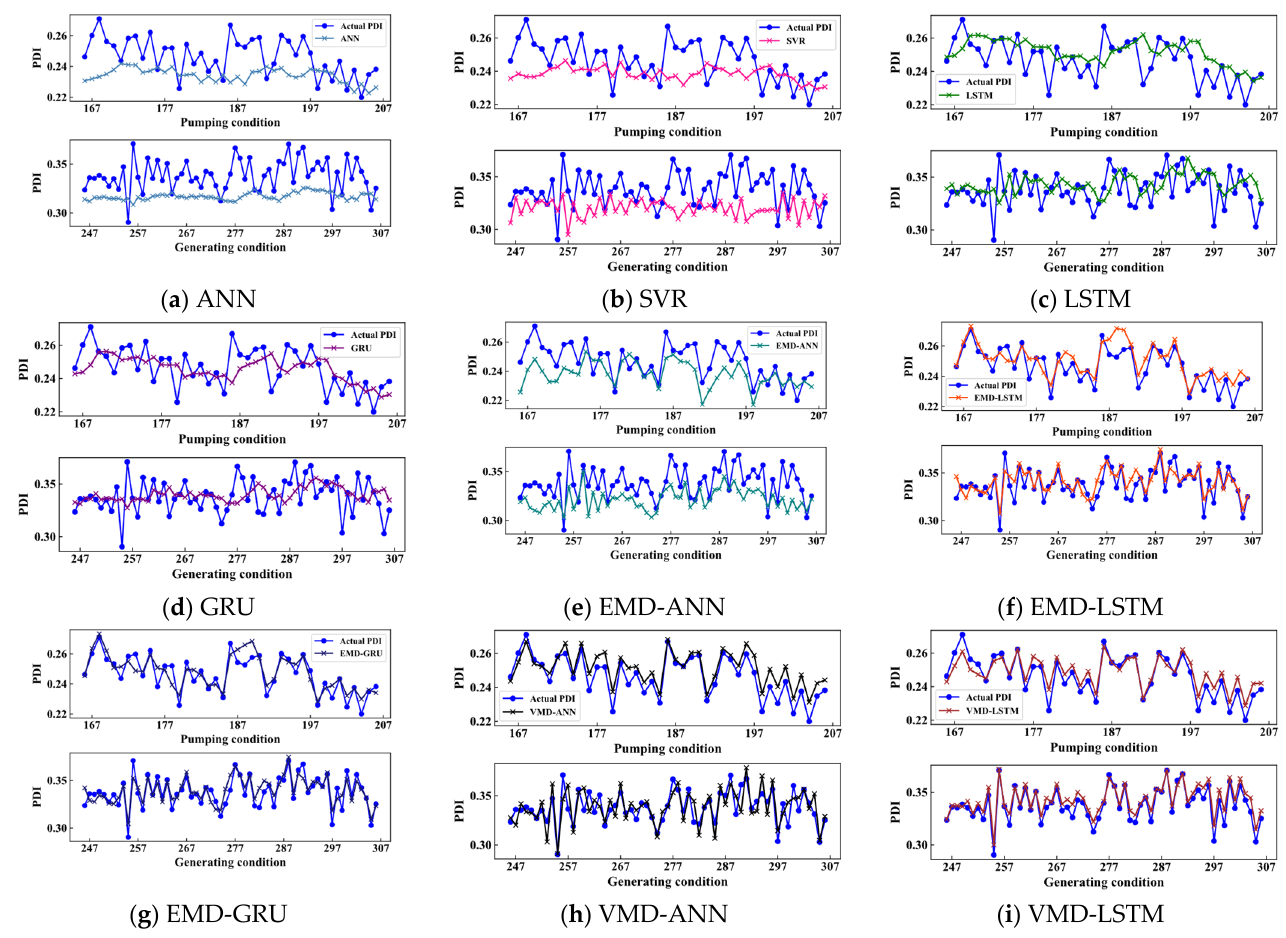
Figure 15. Performance of the comparative prediction models. Table 4. Performance of prediction